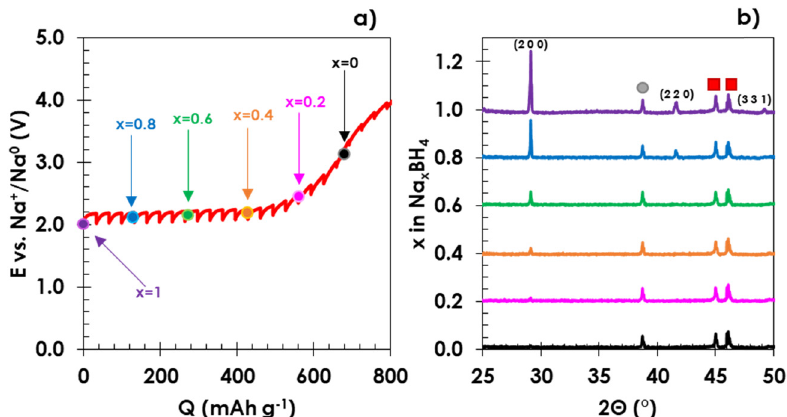
Figure 2: Electrochemical investigation and structural changes in NaBH 4 : ( a ) galvanostatic intermittent titration technique with 1 h current pulse at current C/20 and 1 h OCV ( during OCV period, the XRD spectra were taken ) ; ( b ) structural changes in NaBH 4 presented as XRD spectra observed during the process of sodium extraction.